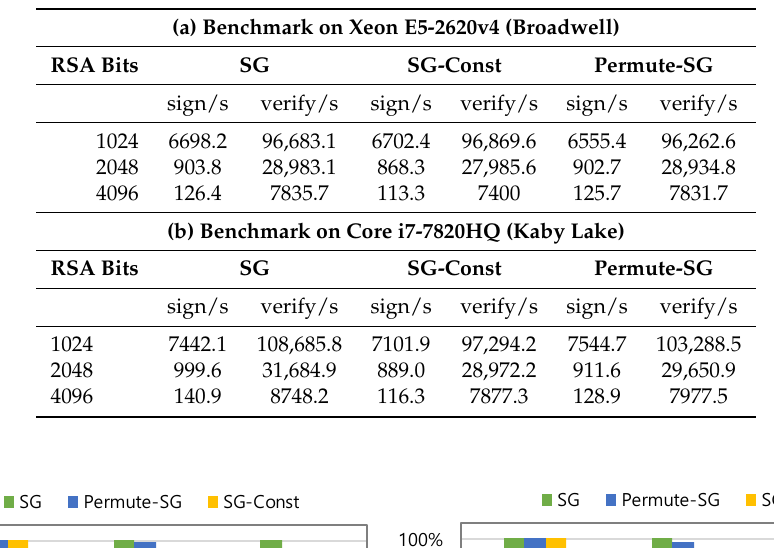
Table 1. The result of performance evaluation.